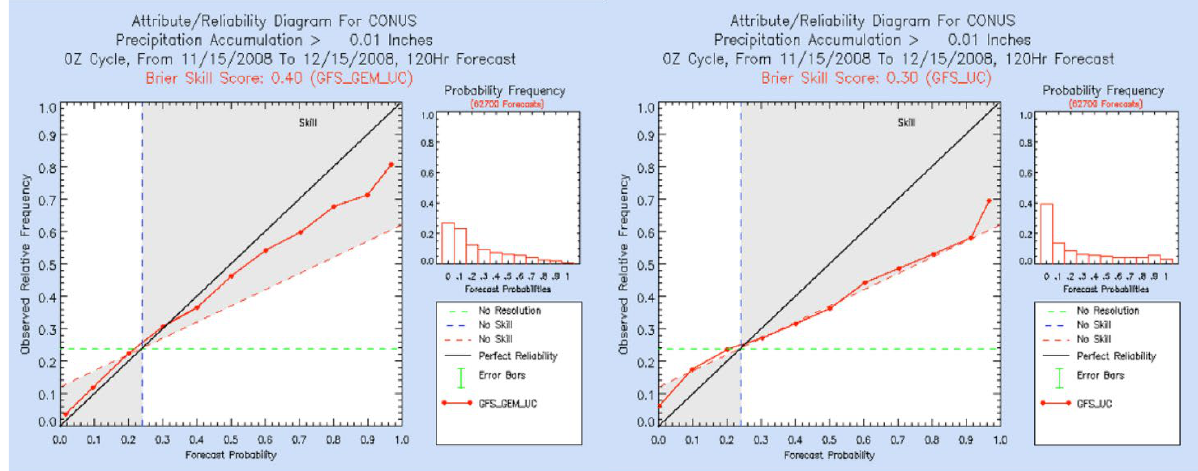
Figure 4. Reliability/Attributes diagram for 120-h forecasts of precipitation greater than 0.01 inches (0.254 mm) compared to precipitation observations in the US using a combined GFS/GEM ( left ) ensemble and only the GFS ( right ) ensemble for 15 November 2008 to 15 December 2008.